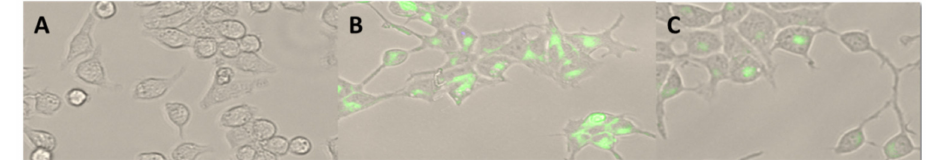
Figure 4. RAW 264.7 cells ( A ) after a 2 h incubation period with PCL NPs ( B ) and PCL-PEG NPs ( C ) (green), which were assessed using fluorescence microscopy. 30 ×